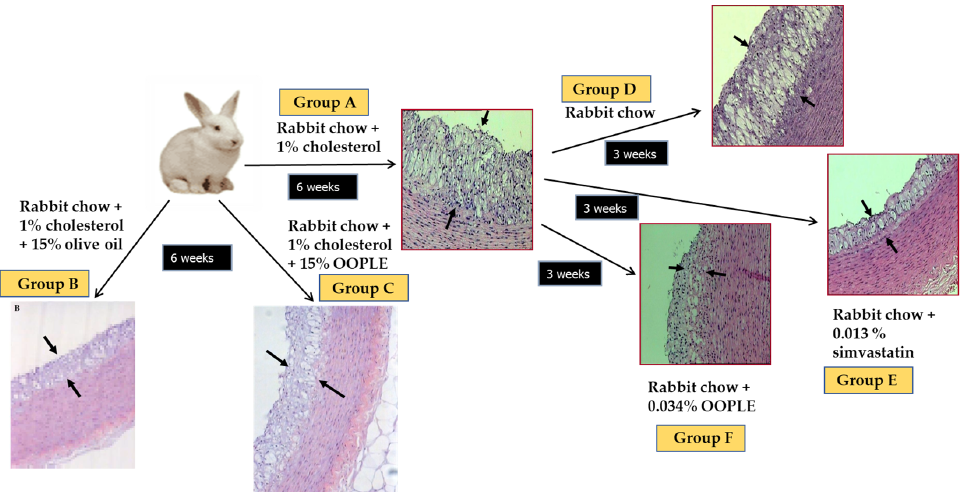
Figure 5. Experimental protocol and representative microphotographs of atheromatous lesions of aortic wall sections obtained from animals. The arrows indicate the observed atheromatous lesions.